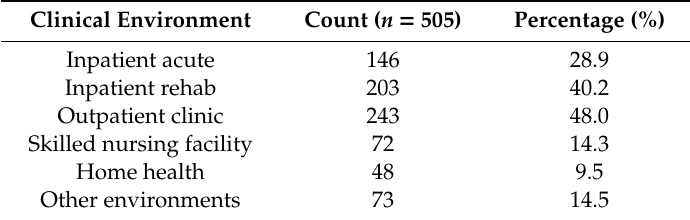
Table 3. Clinical environments of respondents (number and percentage of sample).